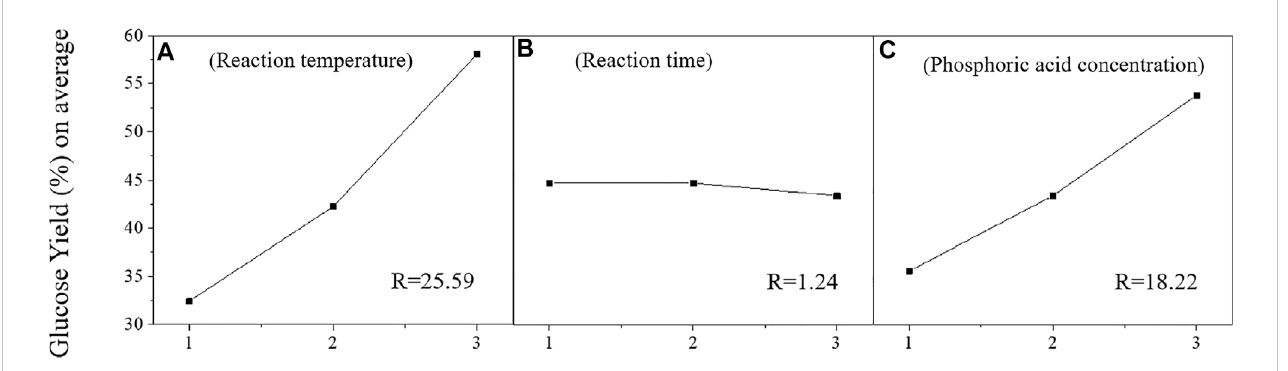
FIGURE 1 Analysis of orthogonal experiment factors on glucose yield [reaction temperature (A) , reaction time (B) , and phosphoric acid concentration (C)